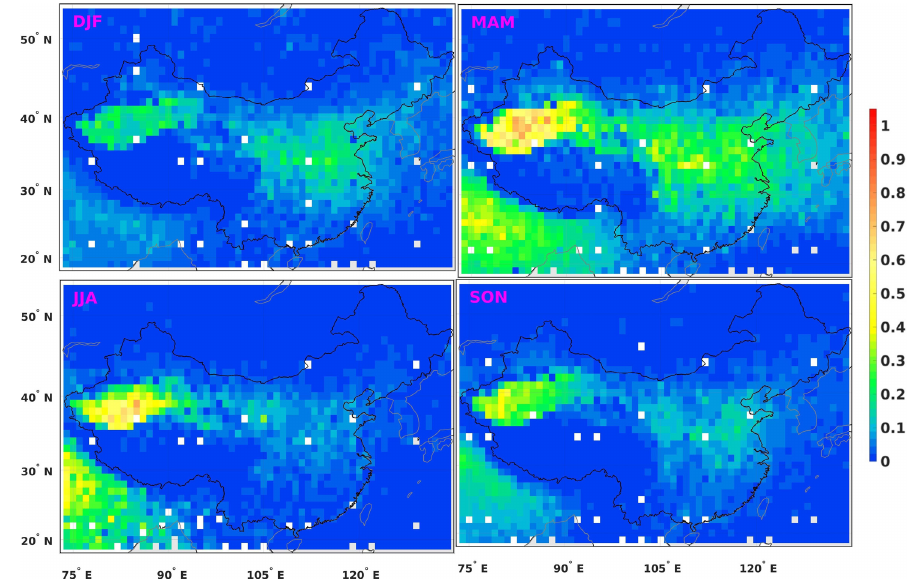
Figure 12. Spatial distribution of the seasonal mean dust AOD, as determined from CALIPSO observations, aggregated over the period from January 2007 to December 2015. Adopted from Proestakis et al. (2018). Chinese borders are indicated by the black line.